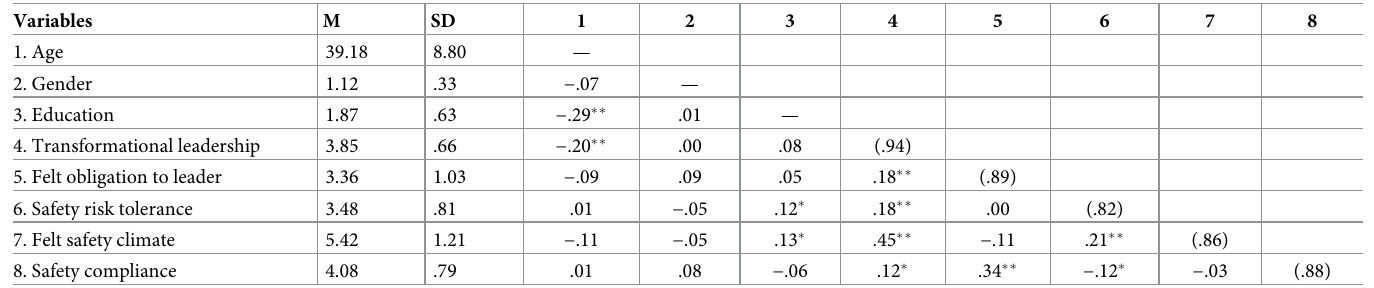
Table 3. Descriptive statistics, reliabilities, and inter-correlations among the hypothesized variables.